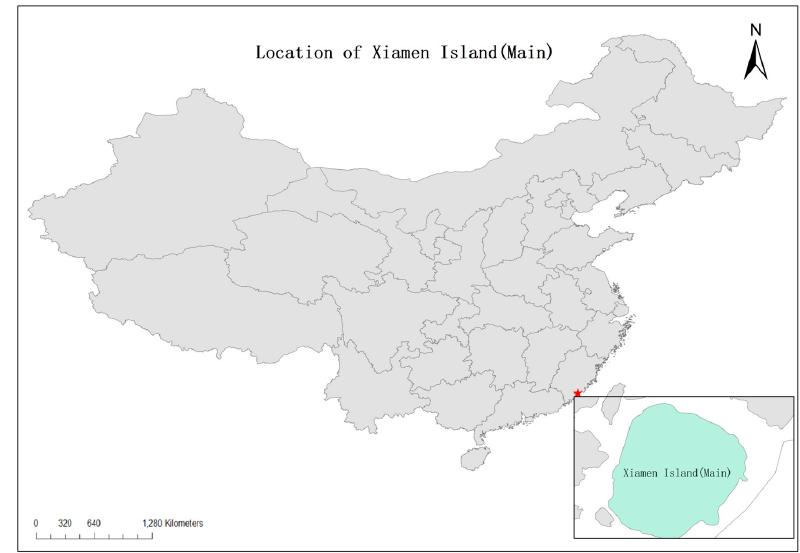
Figure 1. Location of Xiamen Island